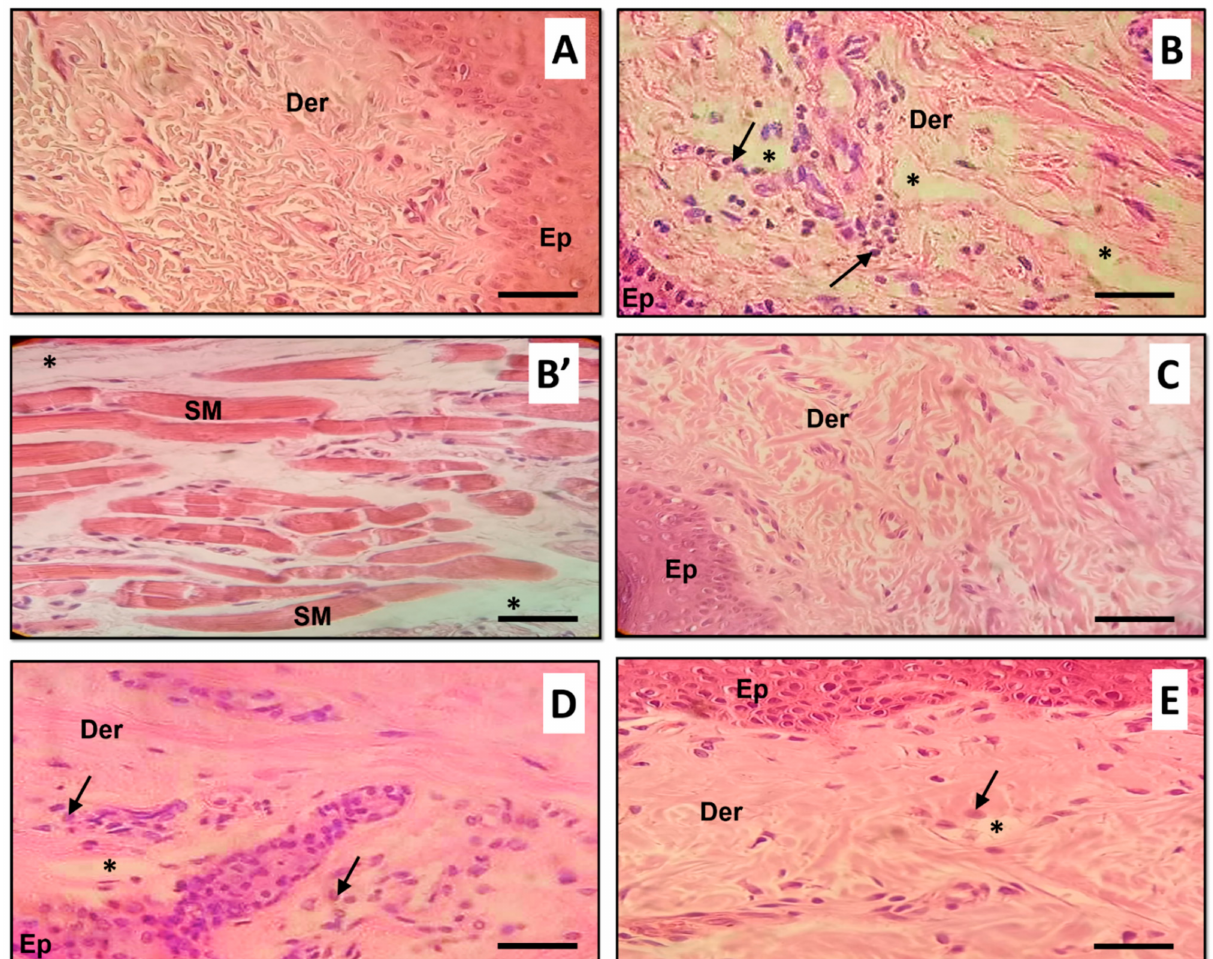
Figure 6. Histopathological examination of specimens from rat paw tissues of all studied groups. ( A ) Control rat treated with physiological saline (NaCl, 0.9%) showing no histopathological changes; ( B ) CAR rat received Carrageenan (CAR, 1%) showing marked inflammatory reaction in the dermis associated intermuscular infiltration with massive number of neutrophils and marked dermis and intermuscular edema ( B’ ); ( C , D ) CAR_ZO and CAR_AS rats treated with ZO or AS respectively for 7 days before CAR injection showing very weak inflammatory reaction once compared with CAR slide; ( E ) CAR_IN rat treated with indomethacin after CAR injection showing moderate inflammatory reaction. Ep: epidermis, Der: dermis, SM: skeletal muscle cells, Arrows: inflammatory cells infiltration, Asterisks: edema. Scale bar = 75 µ